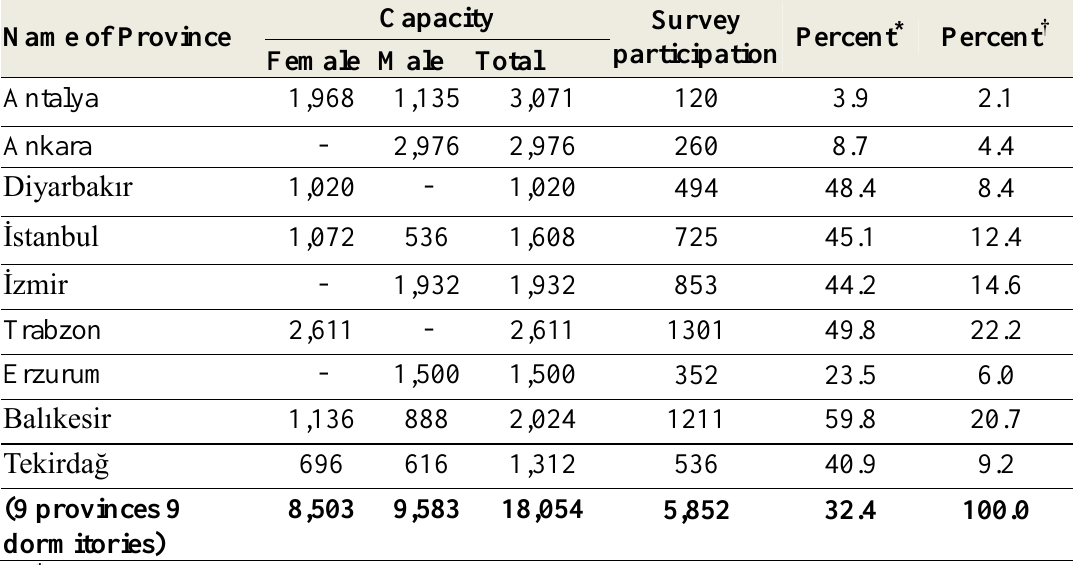
Table 1. Dormitories in the study, occupancy rates and rate of participation in the